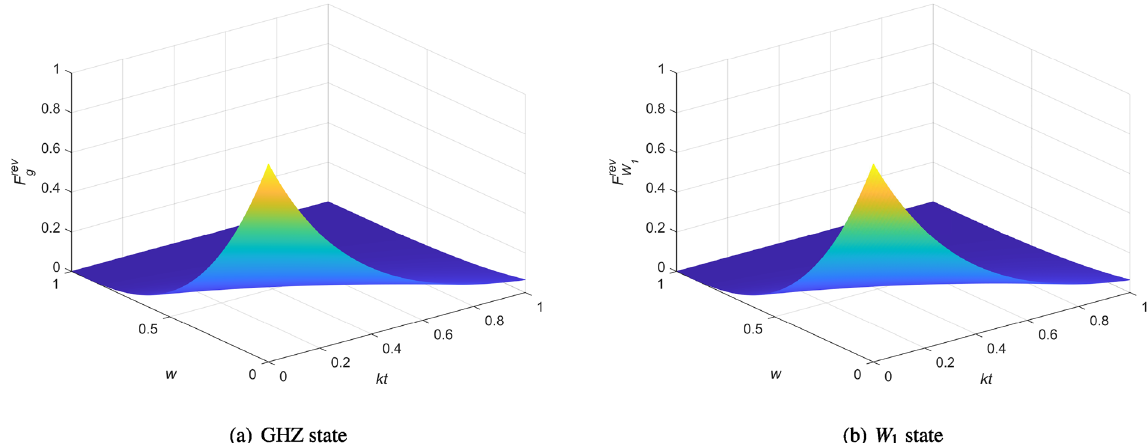
Figure 3. The fidelities of quantum teleportation using three-qubit entangled state with the help of WM and RM under amplitude damping